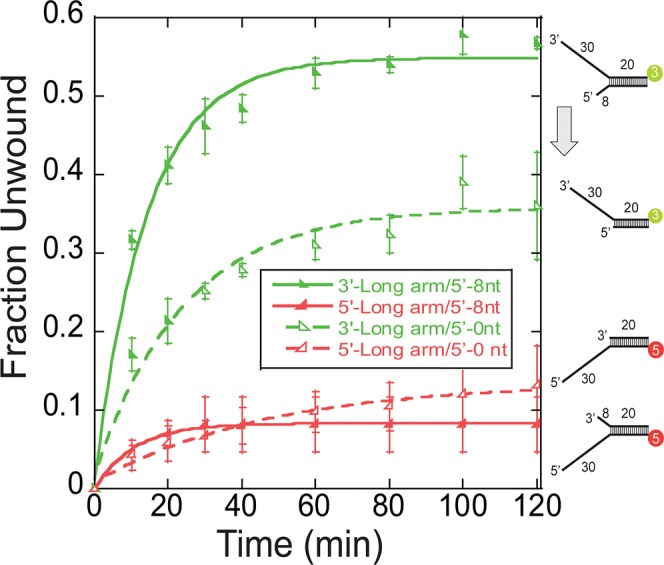
Single turnover DNA Unwinding.DNA unwinding of 3’-long arm/5’-arm (n), (n = 0, in green open lower left triangle -◣-, n = 8 in green closed lower left triangle -◣-,5’-Cy3 labelled at the duplex), 5’-long arm/3’-arm (n), (n = 0, in red open lower right triangle -◢-, n = 8 in red open lower right triangle-◢-, 3’-Cy5 labelled at the duplex) fork DNA substrates with SsoMCM WT. Experiments were simultaneously initiated with ATP and an unlabelled ssDNA trap oligo identical to the labelled strand as described in the Materials and methods. There is a decrease in total DNA unwound with n = 0 compared to n = 8 in 3’-long arm/5’-arm(n) fork substrate (grey arrow). Error bars represent standard error from 3 to 5 independent experiments and data was fit to Equation 3.